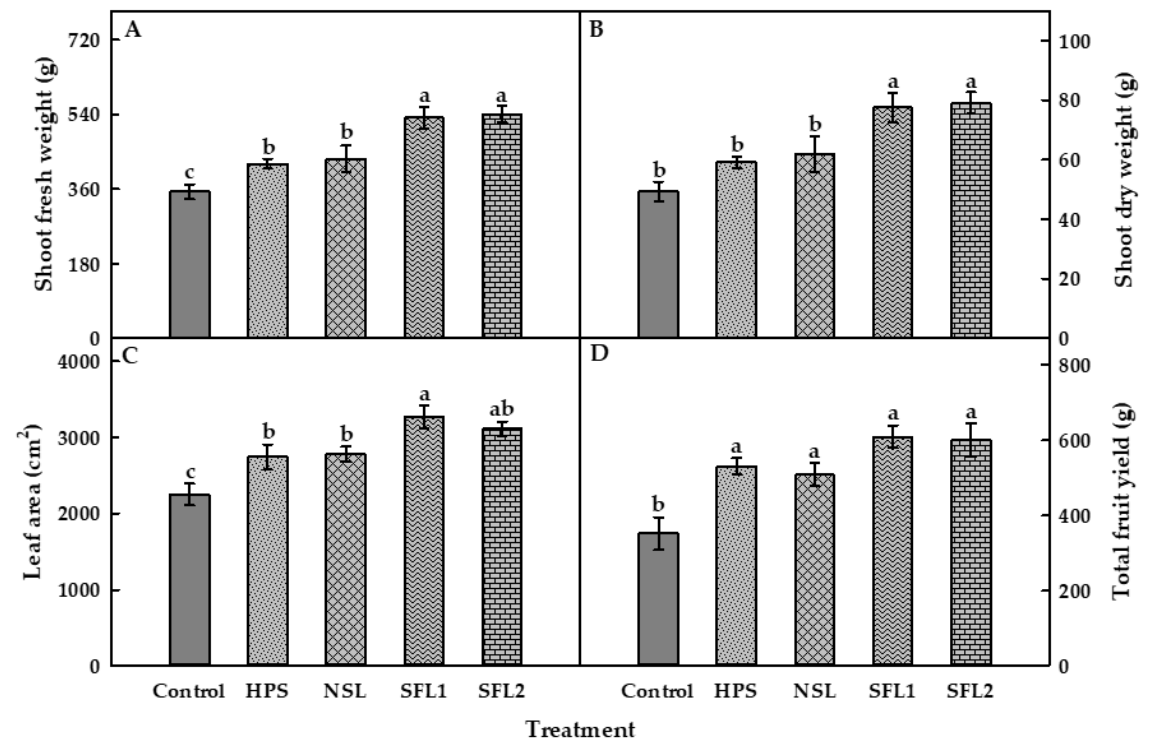
Figure 2. Shoot fresh ( A ) and dry ( B ) weights, leaf area ( C ), and total fruit yield ( D ) of cherry tomato plants grown in different SL sources after 7 weeks of treatment. Control, natural light; HPS, high- pressure sodium lamps; NSL, narrow-spectrum LEDs; SFL, specific full-spectrum or W light sources. Different letters above the bars indicate significant difference at p < 0.05 ( n = 6). Each value in the figure is the mean of 6 replicates (per plant) for each SL source. Total fruit yield was calculated with 5 clusters at each